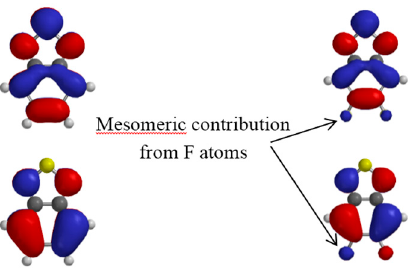
Figure 7. Calculated LUMO ( top ) and HOMO ( bottom ) isovalue contour plots for BT ( left ) and 2FBT ( right ). The arrows indicate the mesomeric contribution of the F atoms in 2FBT.